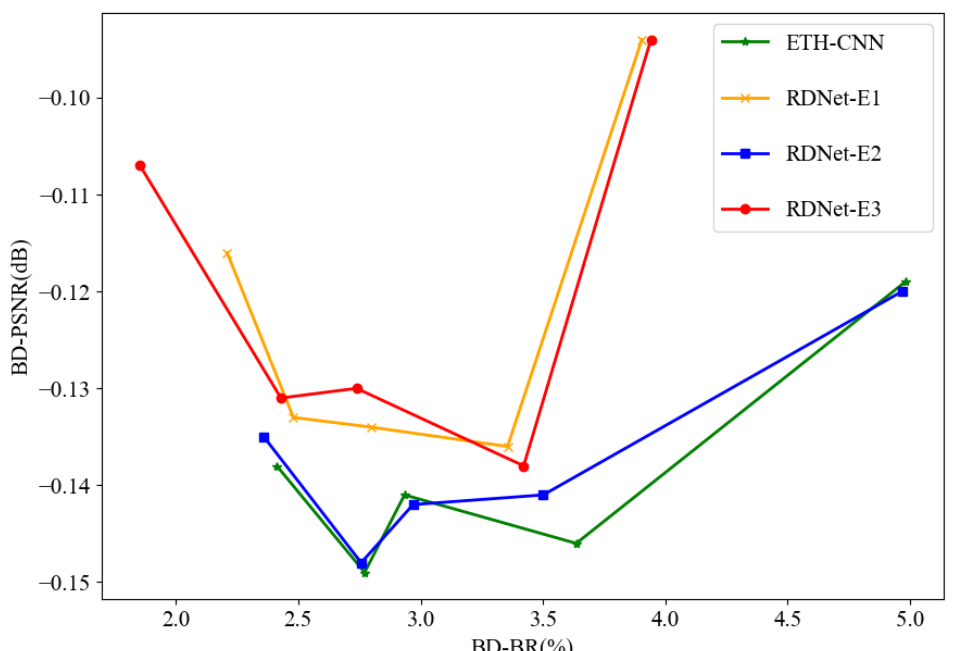
Figure 6. The ablation study results of JCT-VC test set (AI). The closer the data points are to the upper left corner of the graph, the higher the coding quality at a lower coding bit-rate, which means better coding performance. RDNet- E 3 in the figure is closest to the upper left corner, indicating the best coding performance. From the other three curves, it can be concluded that the proposed dual network and dynamic threshold can make the optimization to the traditional